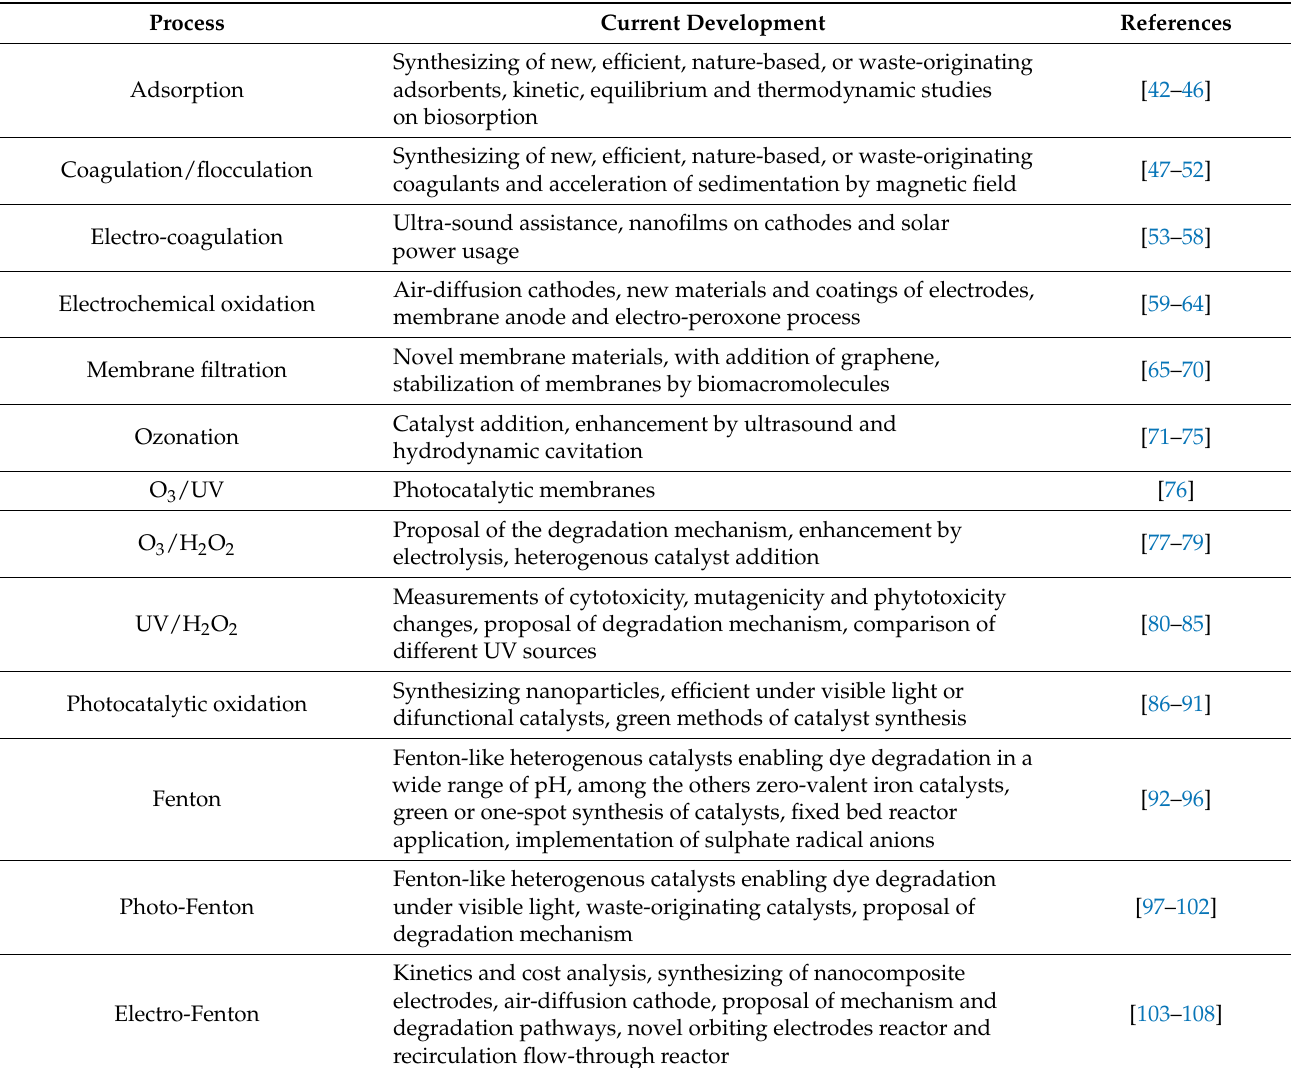
Table 2. Current development in processes used in dye